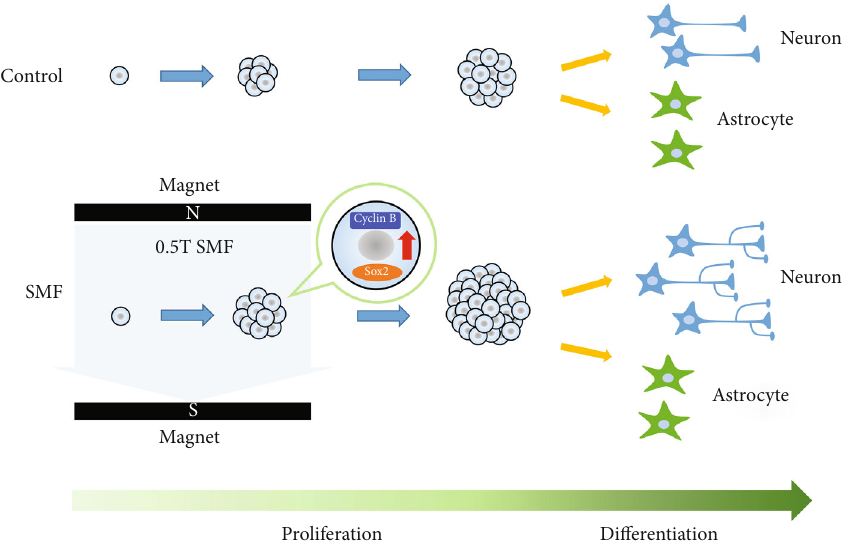
Figure 6: Schematic representation. SMF exposure stimulates mNPC proliferation through upregulation of cyclin B and Sox-2 required for self-replication. Moreover, SMF also promotes mNPC fate determination toward neuronal lineages and neuronal